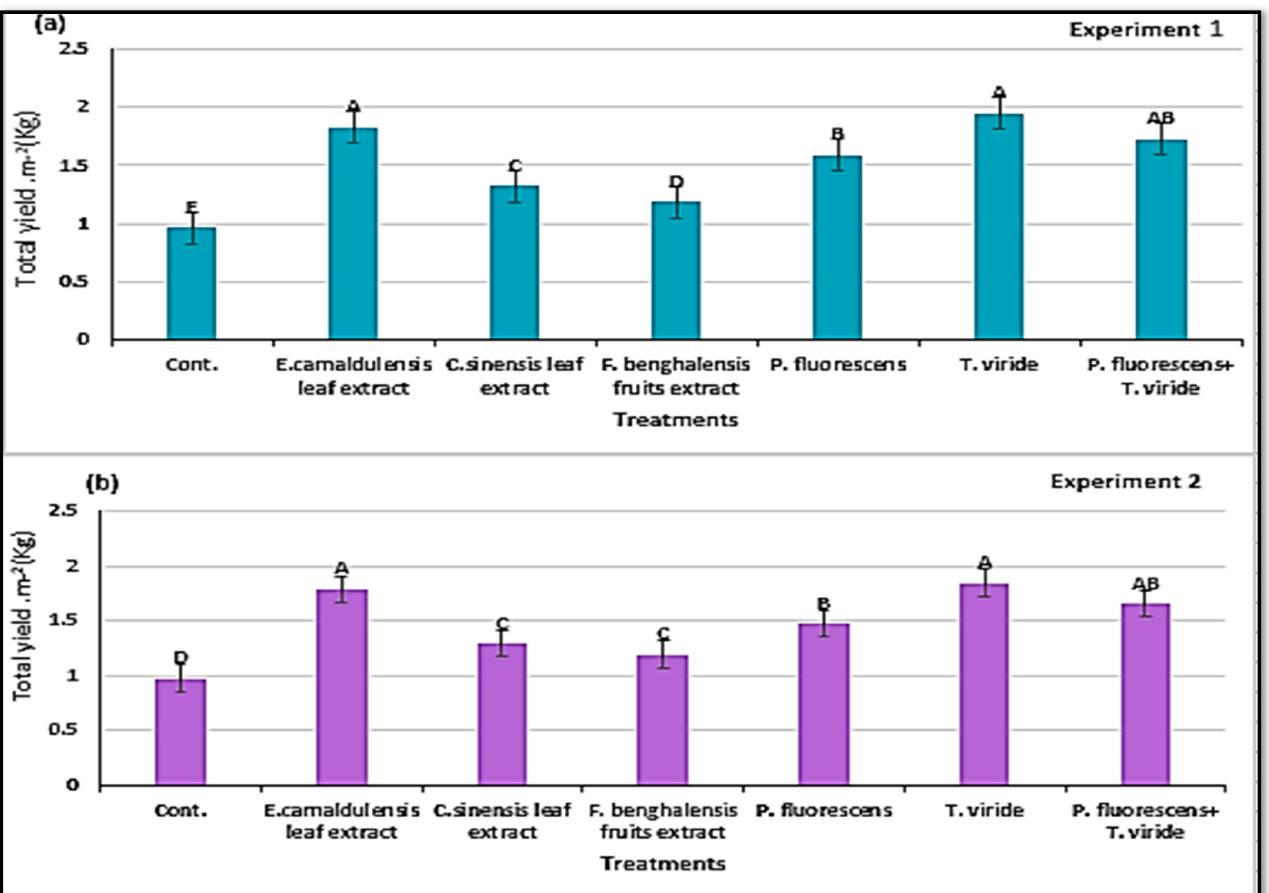
Figure 8. Total yield per square meter (means ± S.E) of zucchini as affected by the natural plant extracts and microbial antagonists. Letters in figure indicate the means ± S.E of treatments with the same letter/s were not significantly different according to LSD at 0.05 level of probability. ( a ) Experiment 1; ( b ) experiment 2.